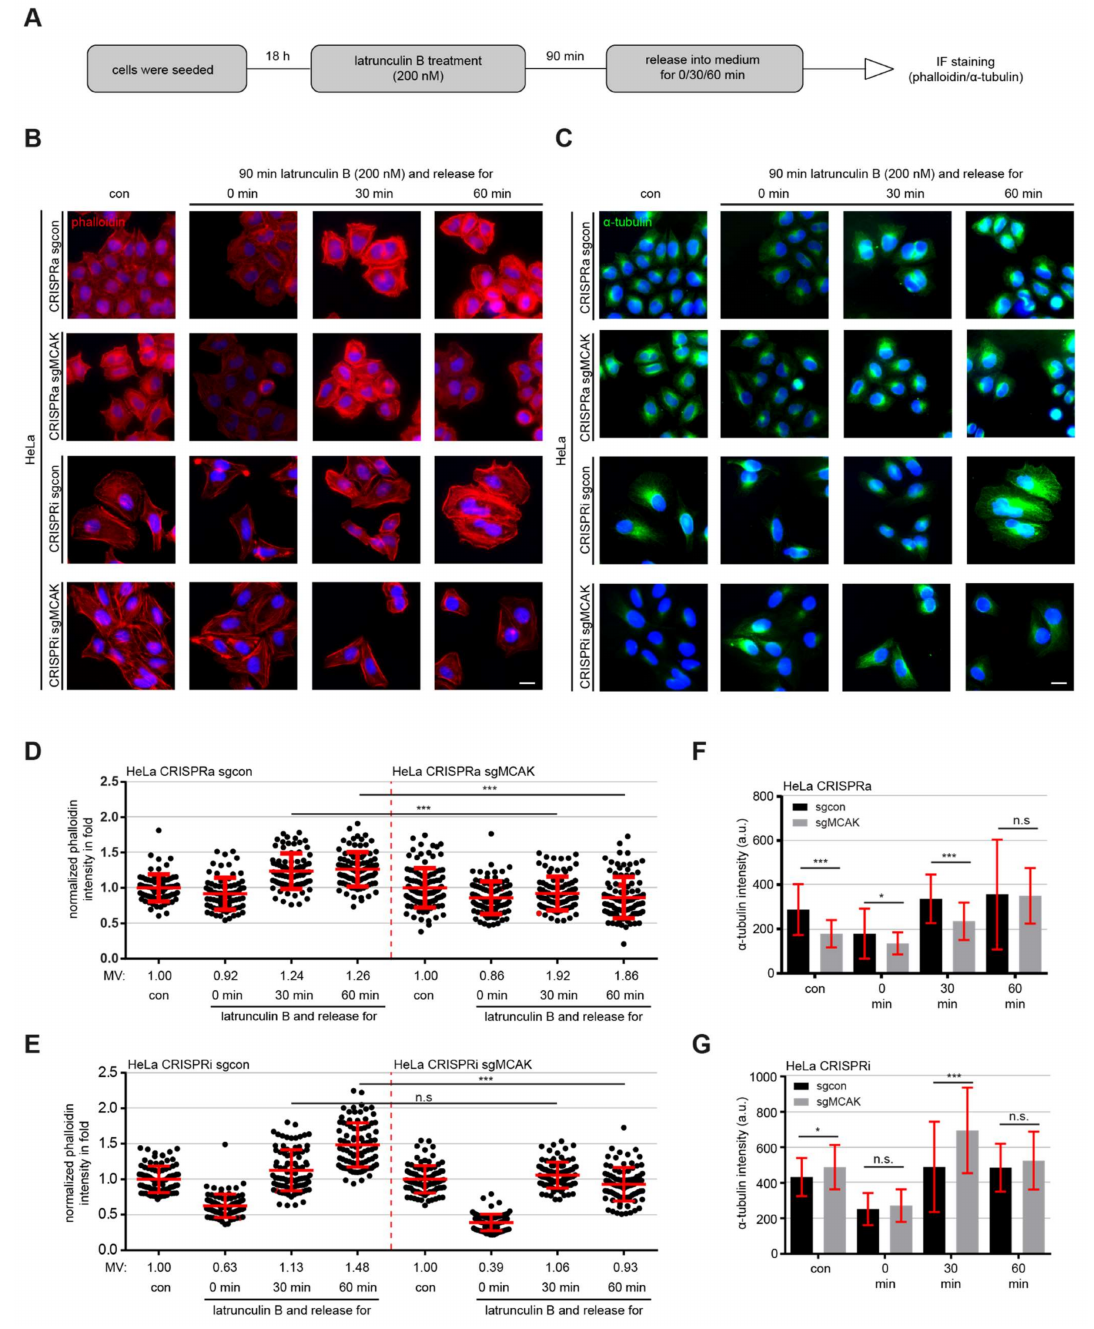
Figure 5. Deficient actin and MT repolymerization after latrunculin B treatment in MCAK overexpressing or knockdown cells . ( A ) Schedule of latrunculin B washout experiment. HeLa CRISPRi/a cells were treated with 200 nM latrunculin B for 90 min and released into fresh medium and incubated for indicated time periods. ( B , C ) The cells were stained for F-actin (phalloidin, red) ( B ) and α -tubulin (green) ( C ). Representatives of actin fiber and MT reassembly are shown. Scale: 25 µ m. ( D , E ) Quantification of the mean fluorescence intensity of F-actin (phalloidin) per cell (30 cells per condition) in HeLa CRISPRa ( D ) and CRISPRi ( E ) cells. The results are based on three independent experiments and presented as scatter plots showing mean ± SEM. ( F , G ) Quantification of the MT repolymerization by measuring the mean fluorescence intensity of α -tubulin (30 cells per condition) in HeLa CRISPRa ( F ) and CRISPRi ( G ) cells. The results are based on three independent experiments and presented as bar graphs showing mean ± SEM. Unpaired Mann–Whitney U test for ( D , E ). Student’s t -test for ( F , G ). * p < 0.05 and *** p < 0.001. Abbreviation: n.s.: not